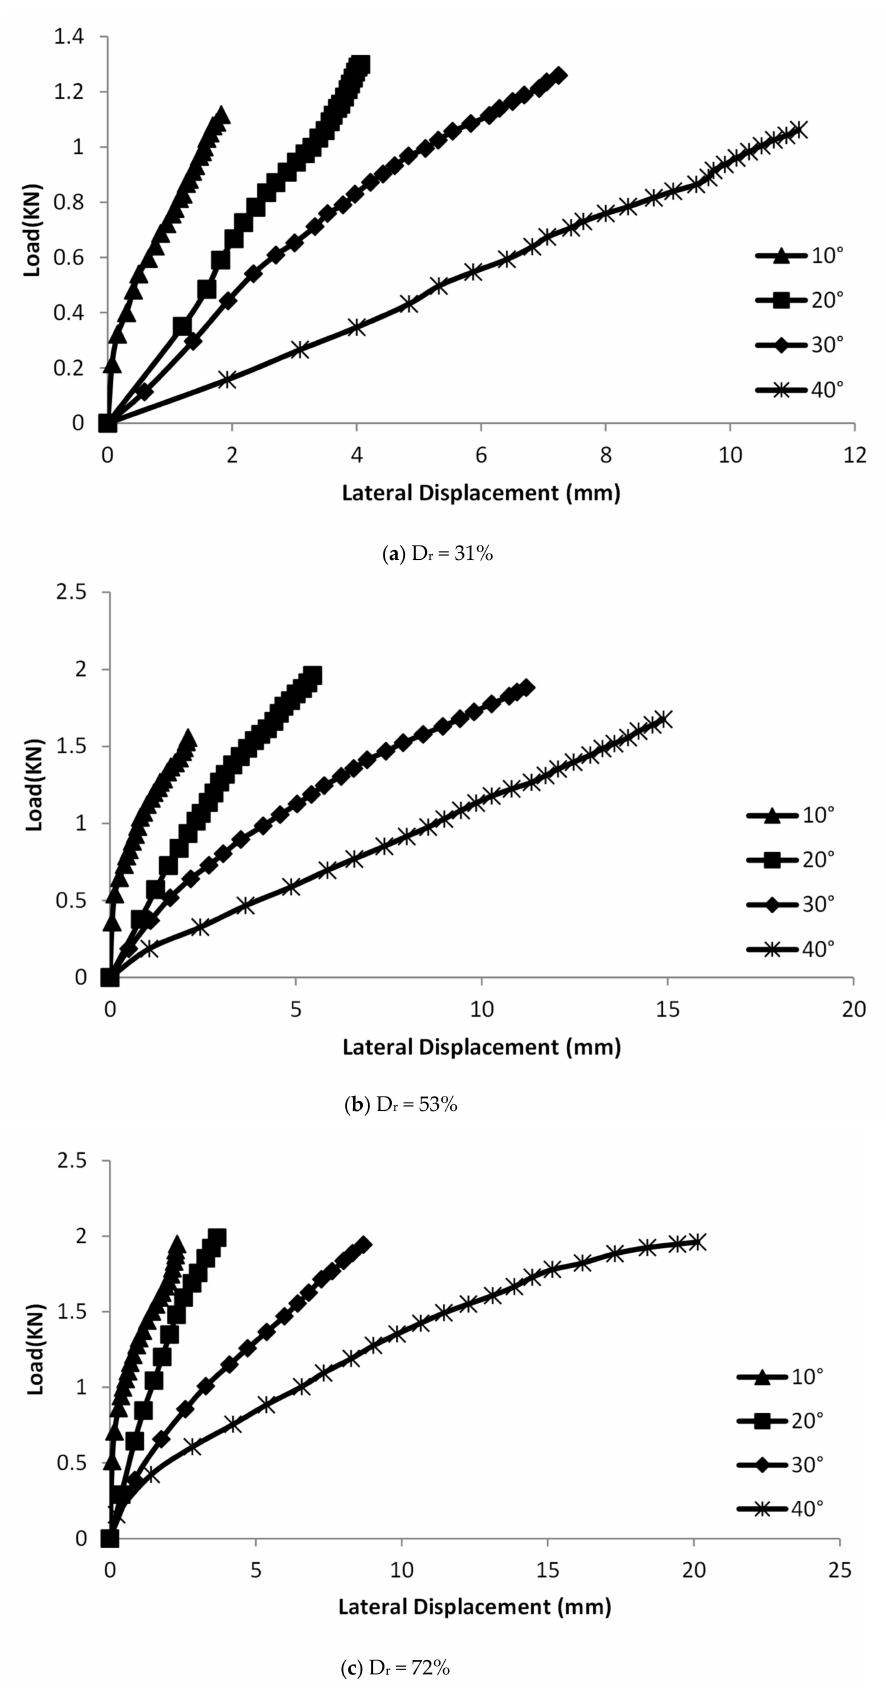
Figure 8. Relation of load and pile head total displacement according to Batter